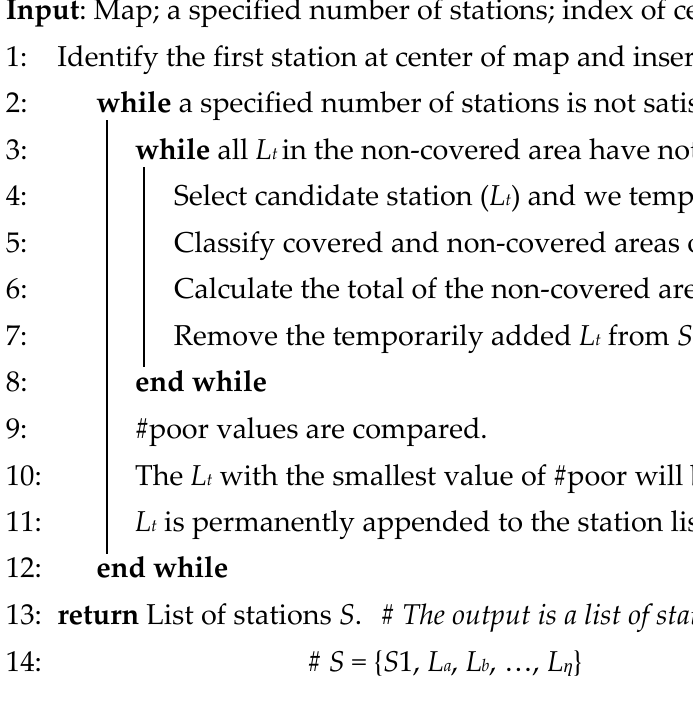
Algorithm 1. Fixed Surrounding Sphere (FSS)